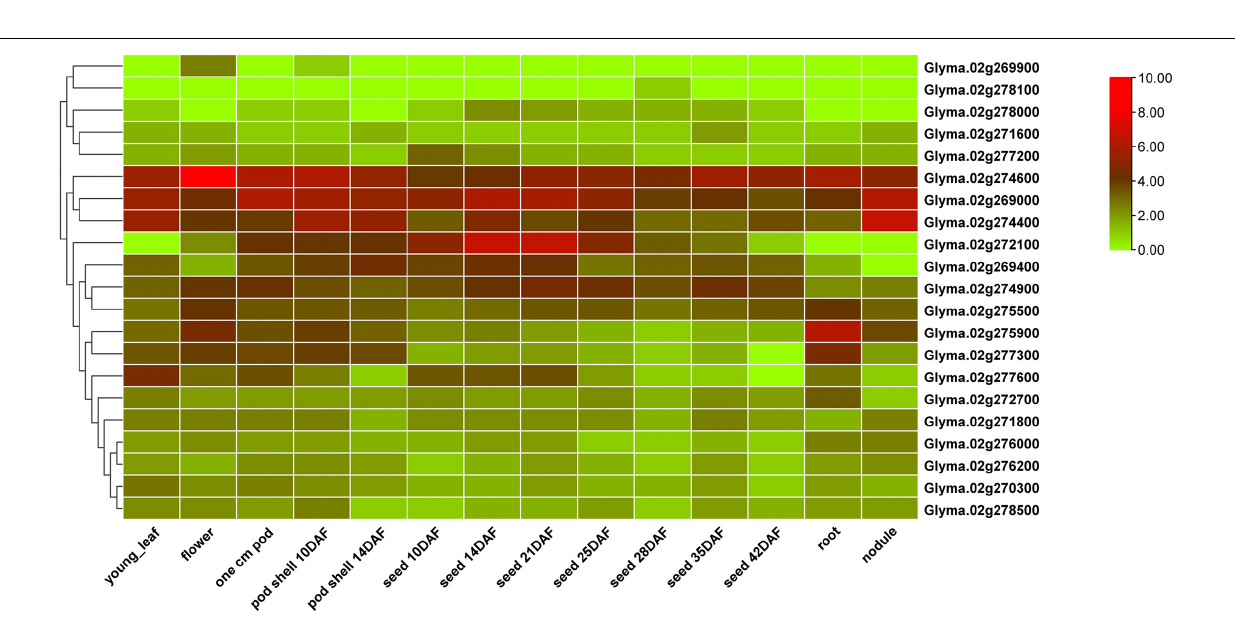
Frontiers in Genetics |